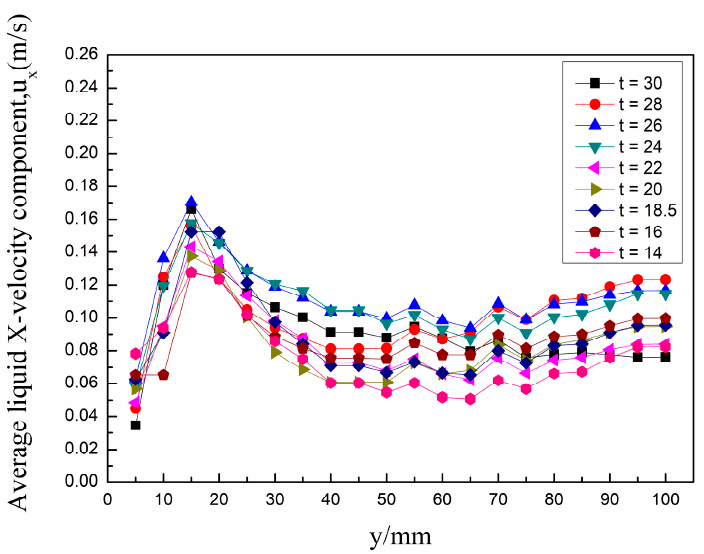
Figure 21. The mean liquid phase velocity trends with the y –direction for the different models.